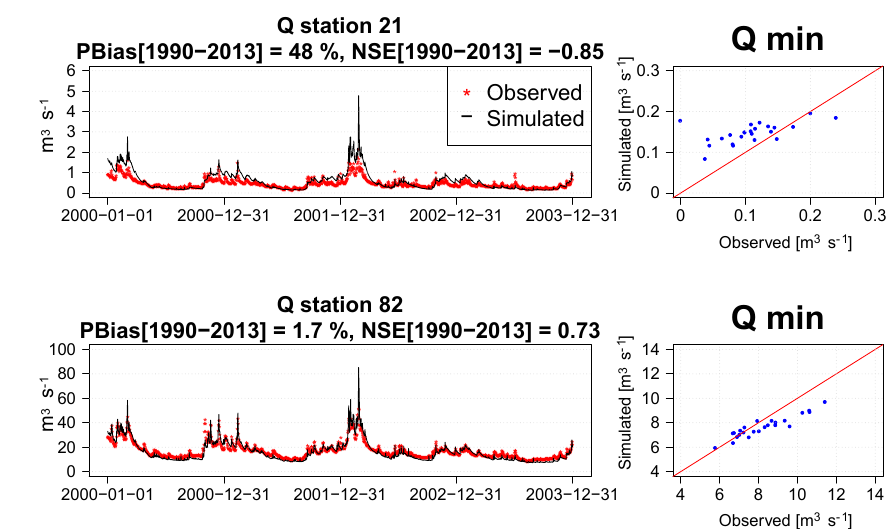
Figure 4. Hydrographs for the 2000–2003 period. Percentage bias (PBias) and Nash–Sutcliffe efficiency score (NSE) are computed using the daily observed–simulated values for the complete 1990–2013 period. The scatterplots represent the observed–simulated annual minimum daily flow